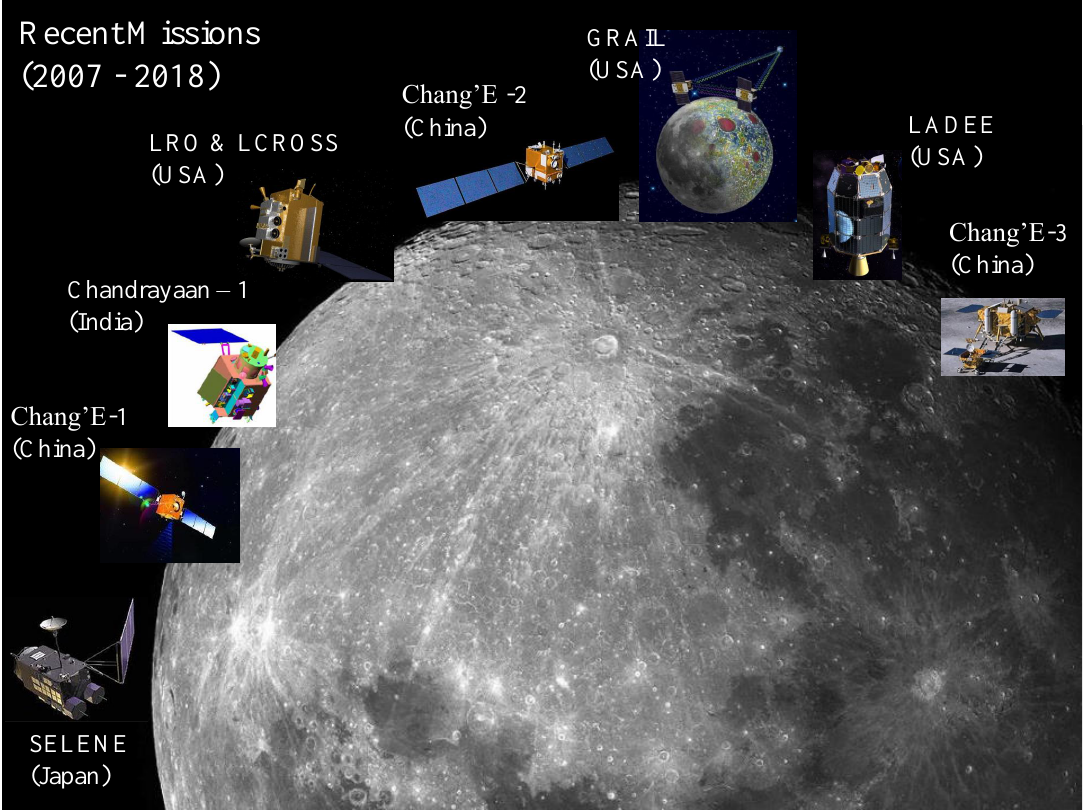
Figure 4. Missions to the Moon in the last decade. Credits for individual images: JAXA, CNSA, ISRO and